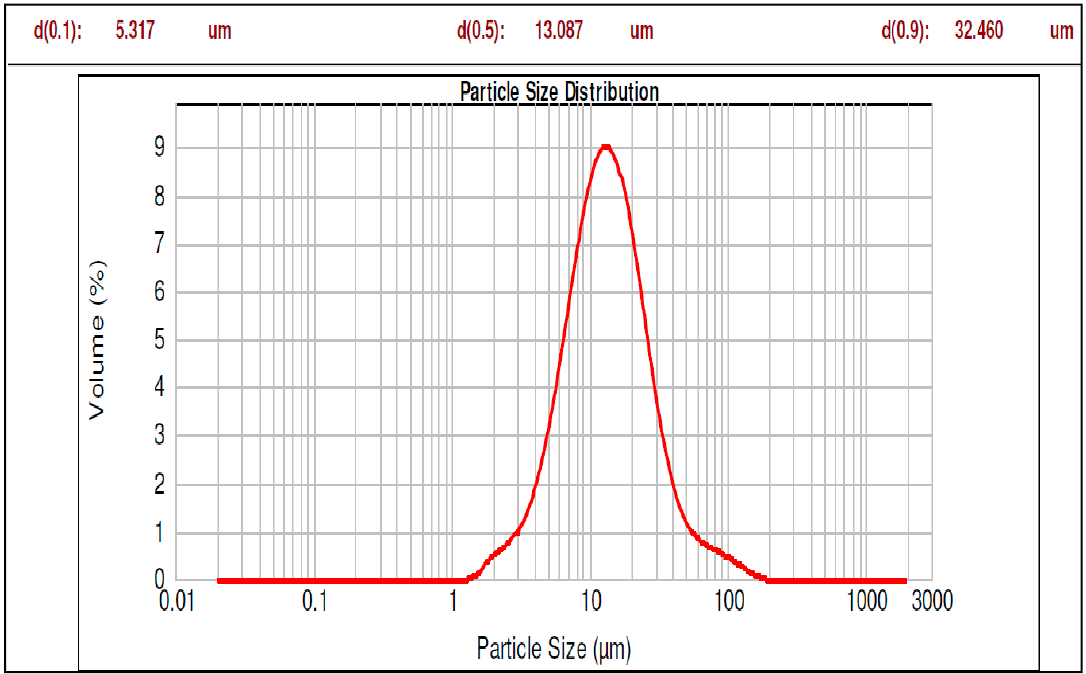
Figure 1. Particle size distribution of LSP (Longan seeds powder).